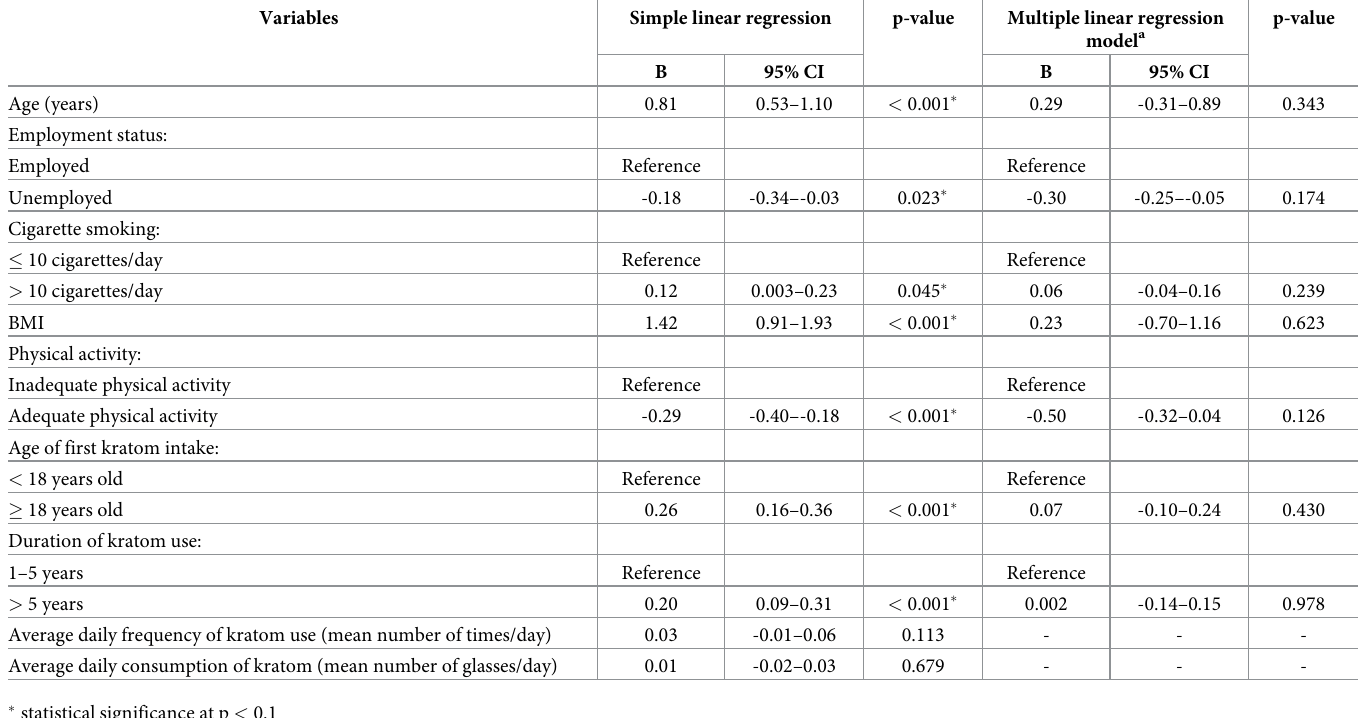
Table 4. Association between kratom use characteristics and serum triglyceride level among kratom users, accounting for confounding factors such as age, employ- ment status, cigarette smoking, physical activity, and BMI.